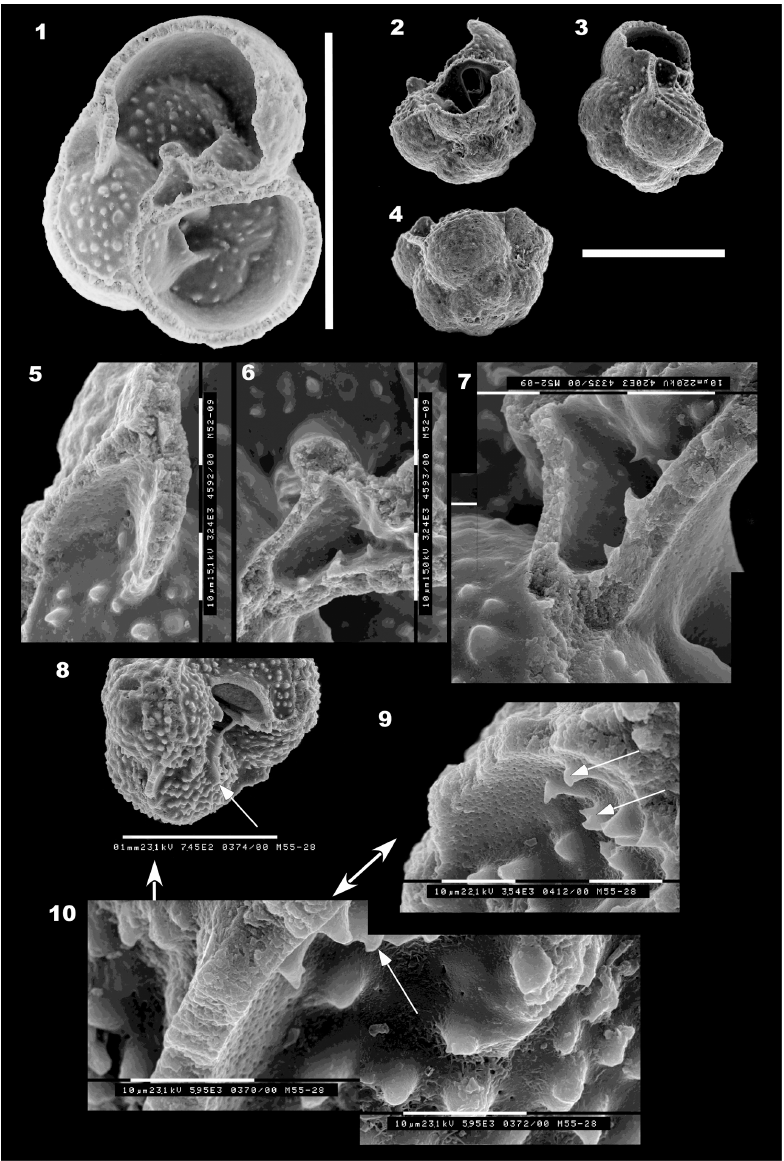
Figure 10. Umbilical structures, apertures and interior of chambers. (1–7) Globuligerina bathoniana australiana n. ssp., specimen WAM 18.20/M52-09. (1) Umbilical overview of broken specimen, showing three apertures, the first two intact with projecting tunnel-like lips, and the third being the broken opening into the chamber at lower left. Scale bar: 100µm. (2) Side view from lower right of (1) , looking across the broken chamber wall at the inner opening of the aperture (dark arch in black wall), which projects into the chamber at upper left in (1) . See also (7) . (3) Side view, specimen at same angle but rotated to the left to look at the bottom of the broken third aperture and its lip. Note the almost flat base of the specimen. (4) Oblique view of the very low trochospire of the first whorl. Scale bar for (2–4) : 100µm. (5) The peripheral base of the lip of the third aperture, coated by inner lamellae on both sides. (6) The inner edge of the third aperture (at left), the hollow triangular pillar formed by successive apertural lips, and the exit edge of the second aperture at the upper right. (7) Same area as in (6) , tilted to show the interior of the arch of the second aperture from the inside of the chamber (at extreme right); plus the top of aperture (1) , at bottom right. For (5–7) , each division of the scale bar: 10µm. (8–10) Globuligerina bathoniana australiana n. ssp., specimen WAM 18.18/M55-28. (8) Specimen tilted to show the broken apertural opening and base of the apertural lips (arrowed), opening into the broken-off final chamber. Scale bar: 100µm. (9) Oblique side view, detail of interior wall structure in the hollow between the apertural lip (at right) and outer wall of the next chamber (at left). Note the hook-like tubercules that appear to be attached to the newly formed wall and appear to have formed after the wall. (10) The same fragment of wall as in (9) , but viewed from above. The floor of the chamber consists of older tubercules from the whorl below (right side of photo), coated with new inner lamella, which bends upwards to form the porous interior of the new wall (left side of photo). The new hook-like tubercules are visible on the wall surface (arrowed). Each subdivision of scale bar: